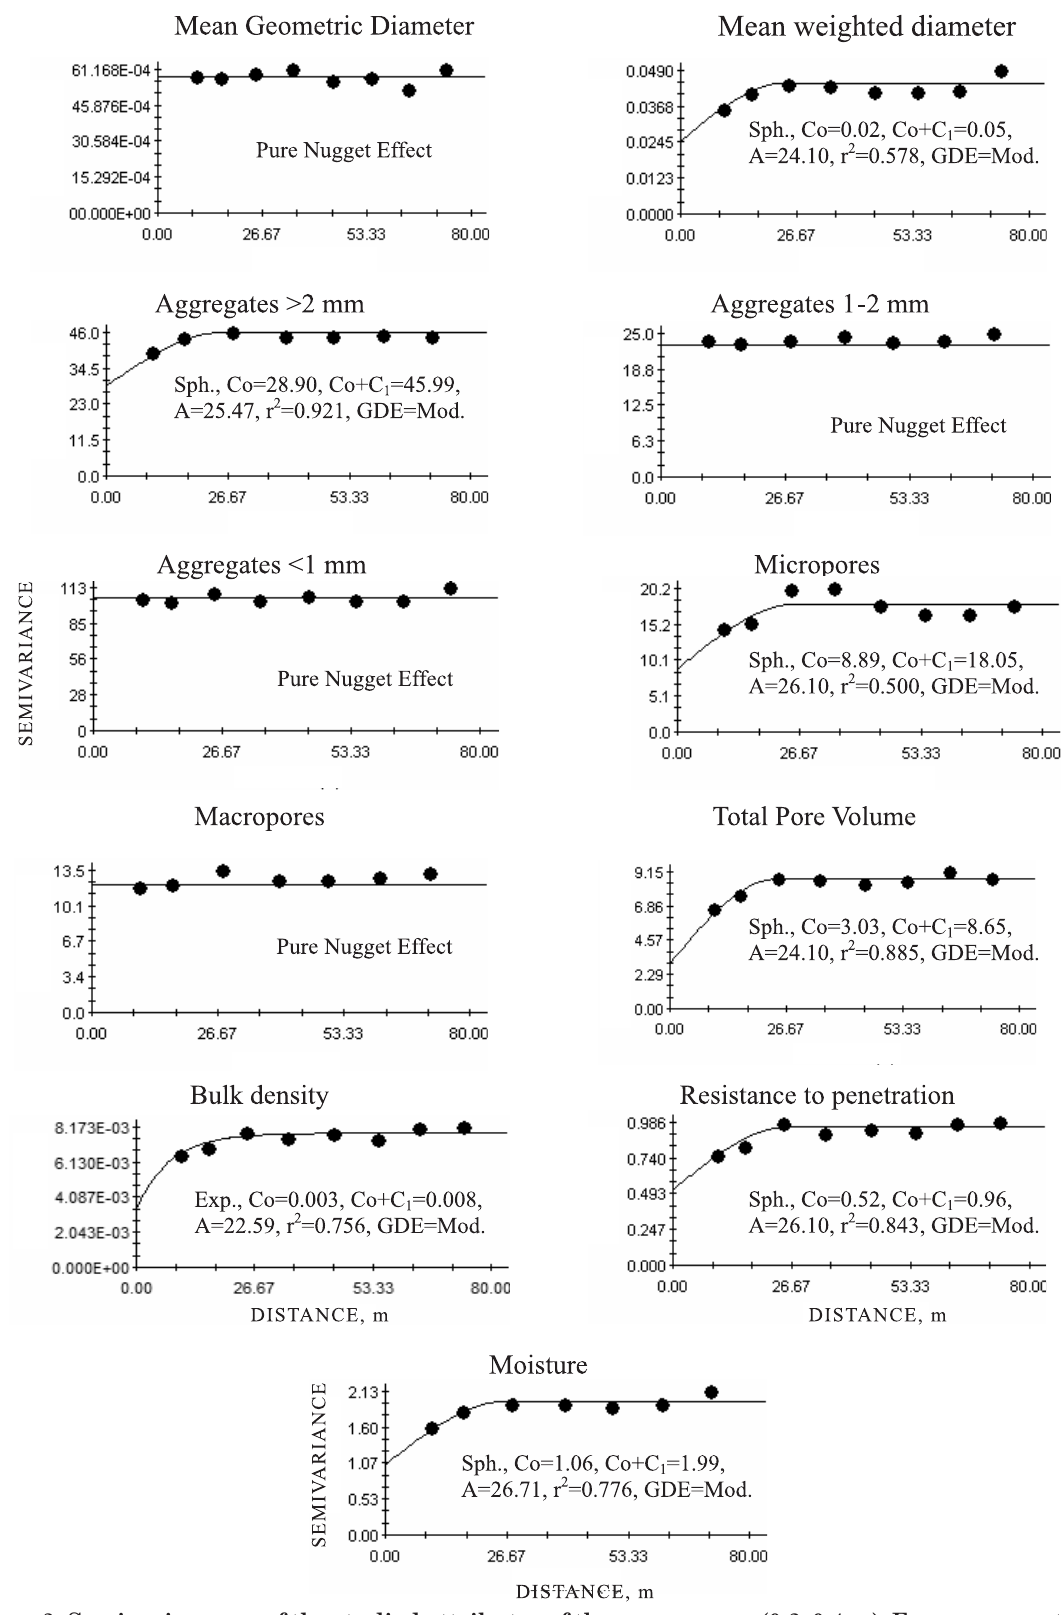
Figure 3. Semivariograms of the studied attributes of the convex area (0.2–0.4 m). Exp.: exponential; Sph.: spherical; Co: Nugget Effect; C : sill; a: range (m); r 2 = coefficient of 1